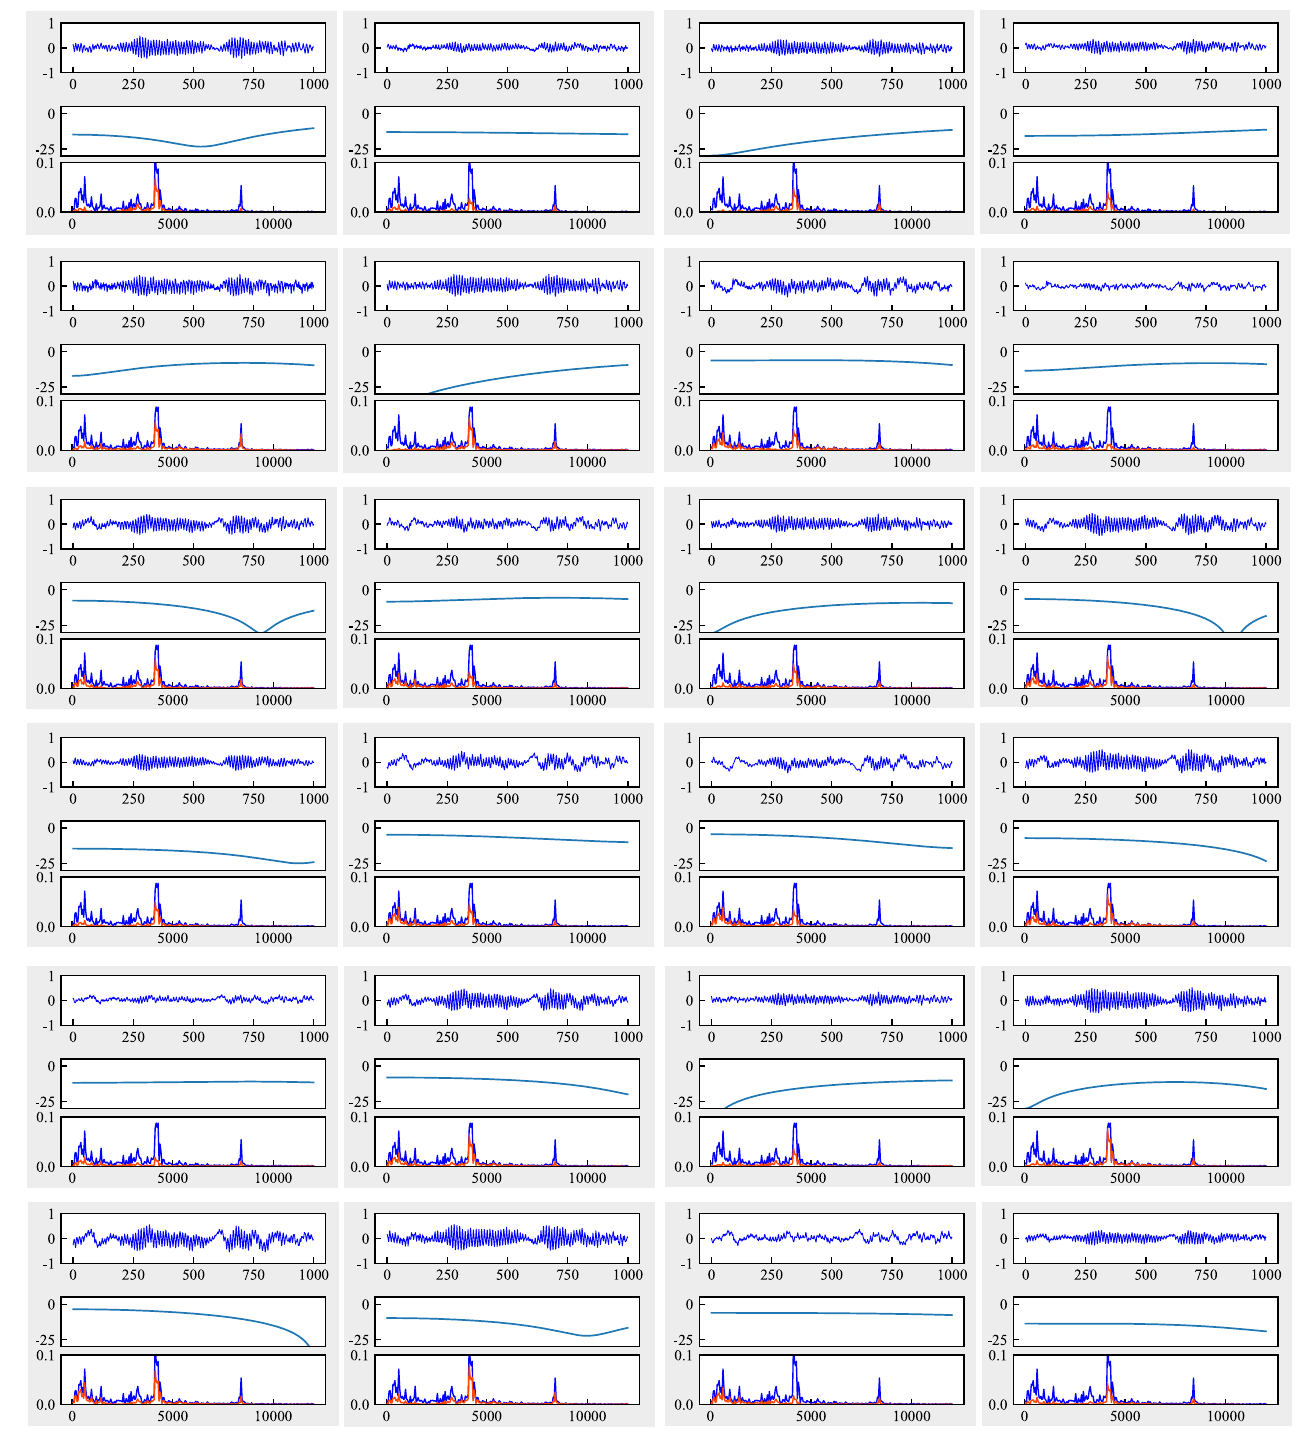
Figure 13. Amplitude-frequency characteristic curves of each filter in the first layer of CNN-maximum mean discrepancies (MMD) from task B 5 → B